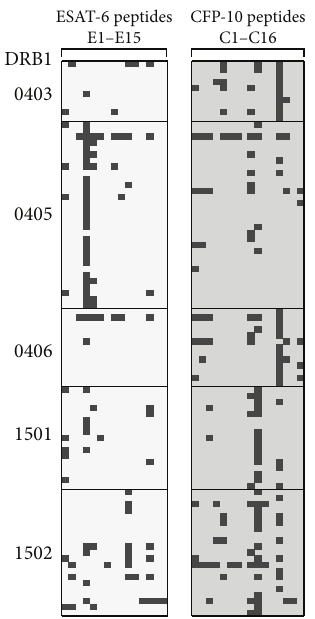
Figure 4: Association between HLA class II DRB1 and epitopes. PBMCs were incubated with a single overlapping peptide from CFP- 10 (C1–C16) or ESAT-6 (E1–E15). The positive well was